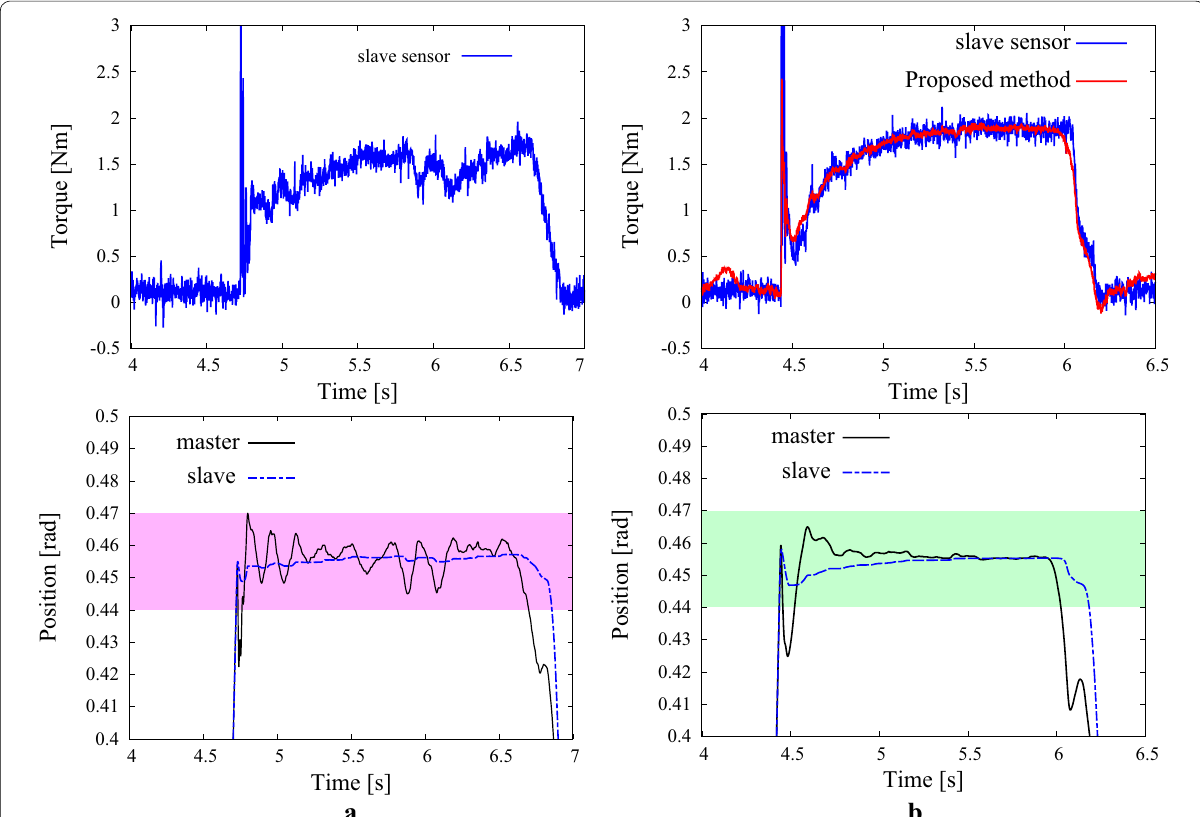
Fig. 18 Enlarged figures for position and force responses of the bilateral control systems. a Bilateral control based on force sensor. b Bilateral control based on the proposed